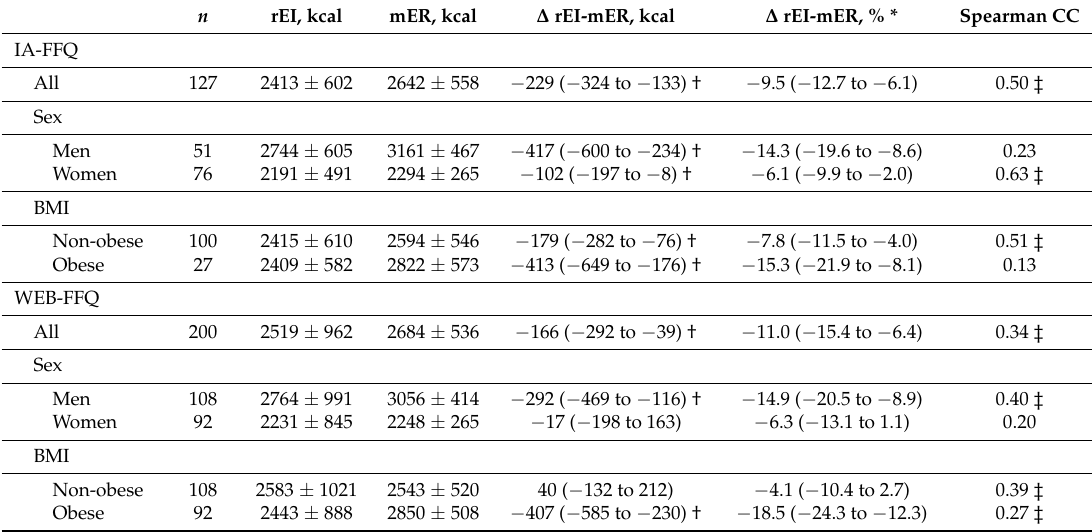
Table 2. Comparison of reported energy intake (rEI) with measured energy requirement (mER) for maintenance of body weight during a controlled feeding phase of 4 to 6 weeks 1 .